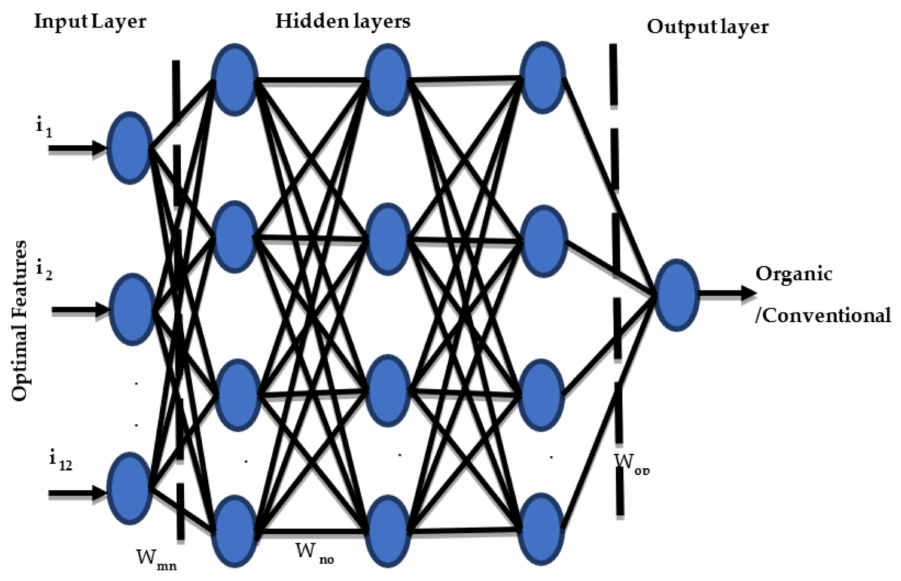
Figure 2. Neural network architecture.